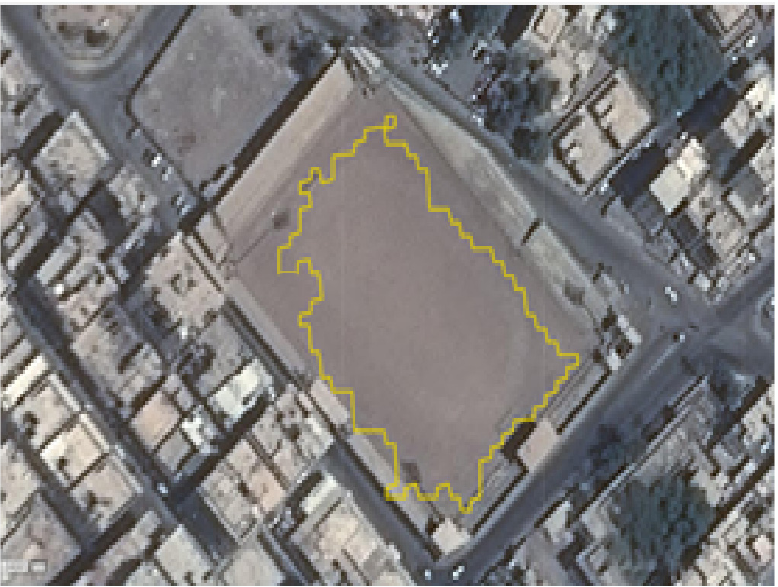
Figure 13. Six safe landing zones (SLZs) have been identified for a helicopter and projected onto an aerial map without using the feature detection method.